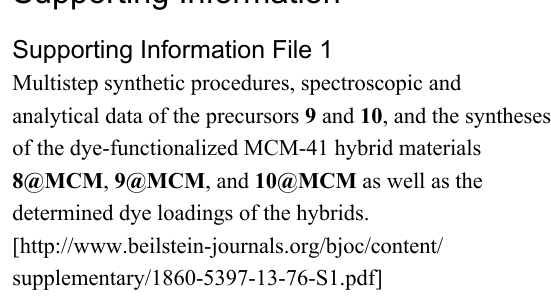
ized materials since their quantum yields could show higher efficiencies in comparison to the powder samples due to elimi- nation of scattering of the excitation and emission light in the silica